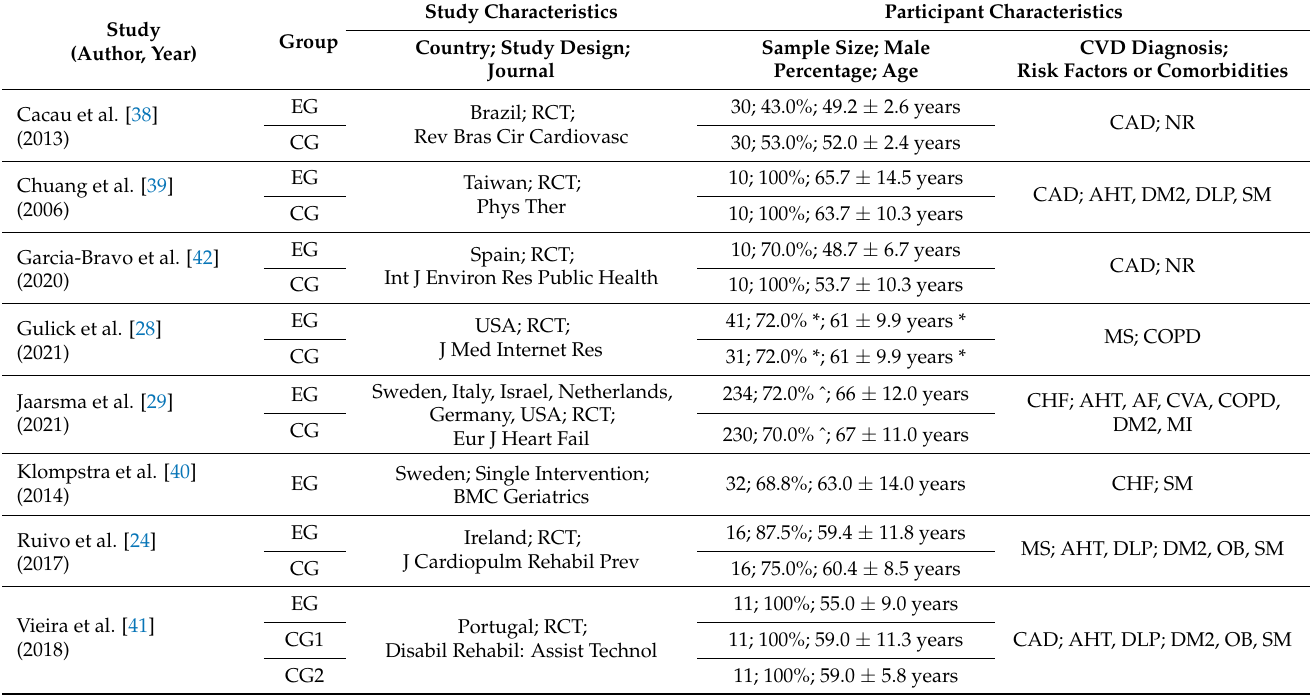
Table 1. Study and participant